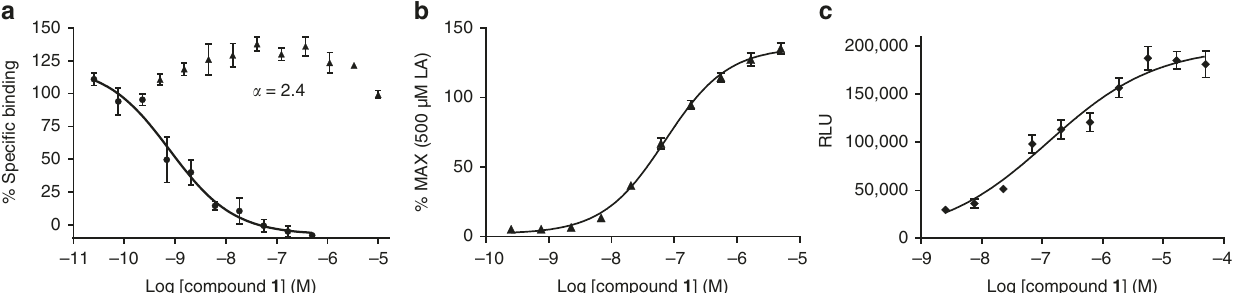
Fig. 1 Ligand binding and functional assays of compound 1 . a Competitive radioligand binding for compound 1 . GPR40 membranes (prepared from stably transfected cells) were incubated with either [ 3 H]-TAK-875 (triangles), n = 3, or [ 3 H]-AM-1638 (circles), n = 4, in the presence of unlabeled compound 1 , as described in the Methods section. Percent speci fi c binding ( y -axis) was plotted against the log concentration of compound 1 ( x -axis) and fi t with a four parameter nonlinear logistic curve function with variable slope (GraphPad Prism, v7.00). The K i for compound 1 in [ 3 H]-AM-1638 binding was 0.81 nM. An inhibition curve for [ 3 H]-TAK-875 binding was not drawn since the addition of compound 1 resulted in enhanced binding activity. Data points represent the mean of single concentration determinations of independent experiments performed on different days with the same stock sample of compound. Error bars indicate the s.e.m. The af fi nity modulation factor ( α ) was calculated using the allosteric modulator titration equation within GraphPad Prism. b Ca 2+ mobilization assay (FLIPR ® ) using stably transfected cells. GPR40- G α q signaling by compound 1 (triangles), n = 4. compound 1 acts as a full agonist relative to 500 µ M of the natural ligand, linoleic acid. (EC 50 ~72 nM; Top = 136.3%; error bars indicate s.e.m.) c cAMP accumulation assay using stably transfected cells. Level of cAMP is measured as relative luminescence units (RLU). GPR40-G α s signaling by compound 1 (diamonds), n = 6. (EC 50 ~125.8 nM; error bars indicate